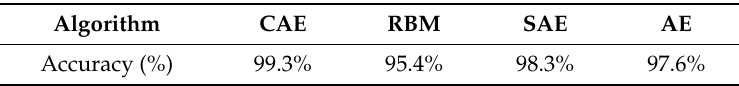
Table 8. Correct differentiation rates of different deep learning